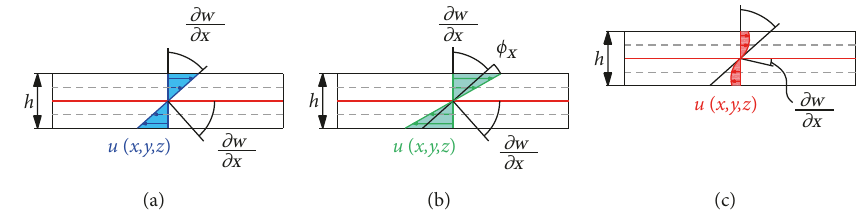
Figure 2: Deformed line element in the CLPT (a), FSDT (b), and HSDT